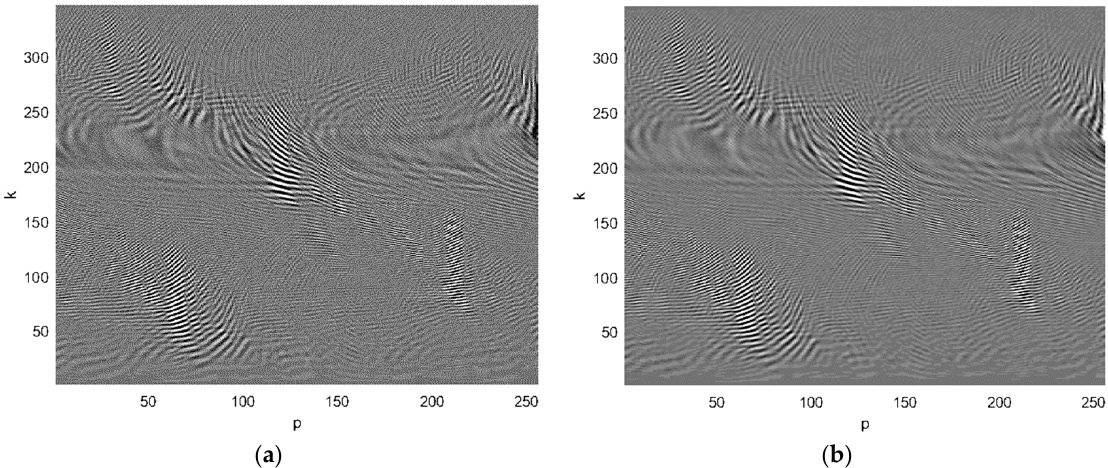
Figure 3. The quadrature components of the complex SAR signal, the real part ( a ) and the imaginary part ( b ).